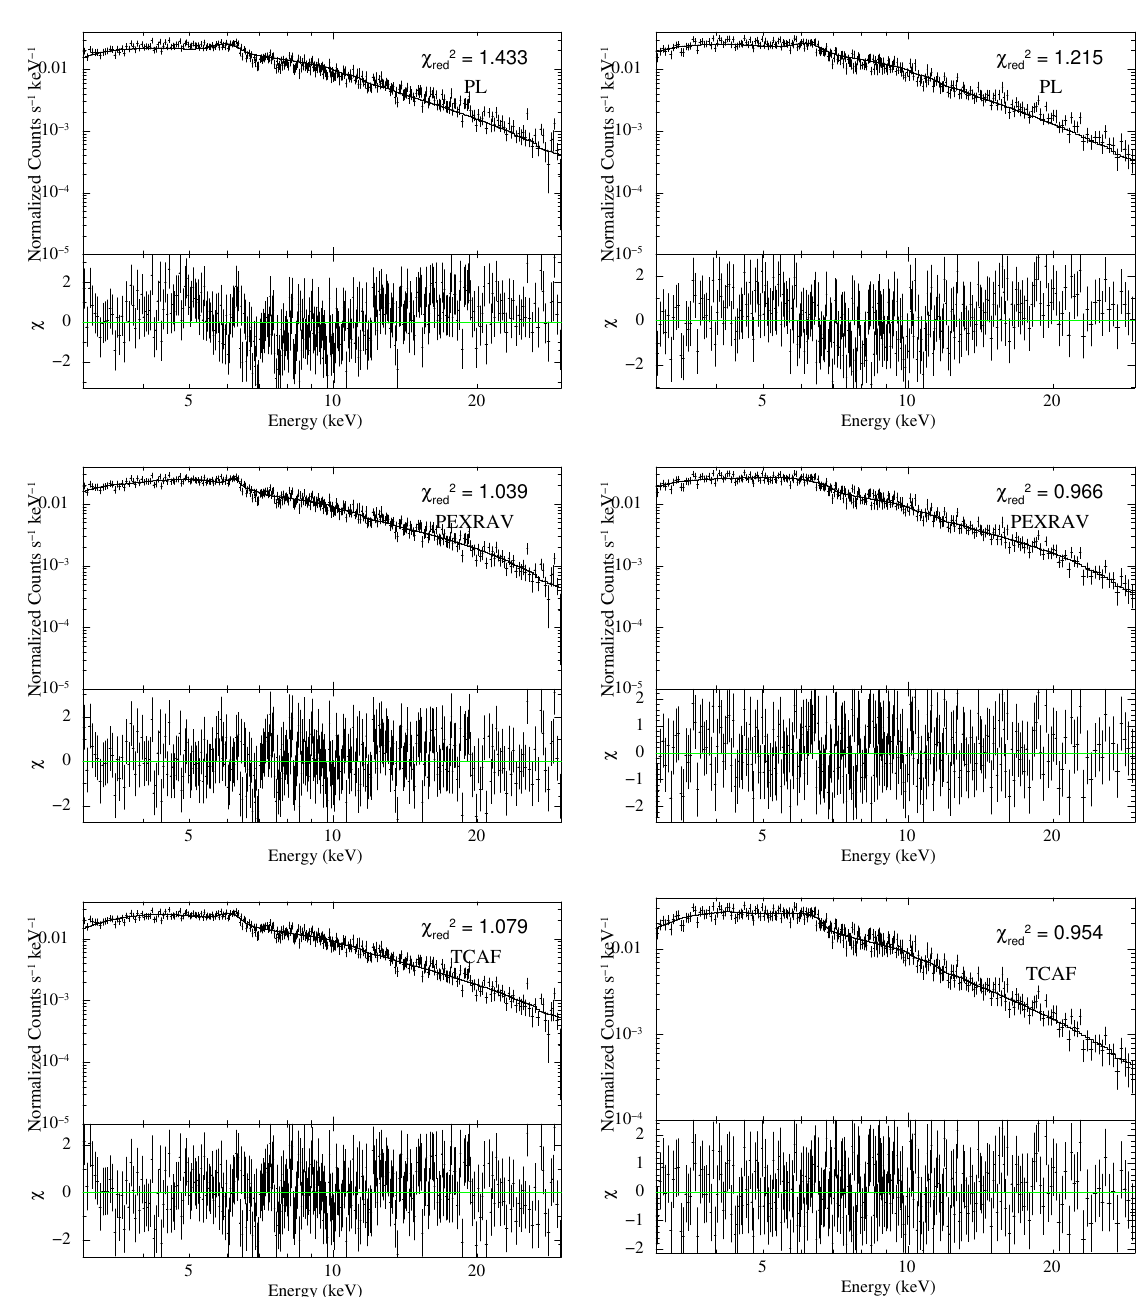
Figure 3. Same as Figure 2 but for the OBSIDs 60001041005 ( left panel ) and 80001020002 ( right panel ) along with the